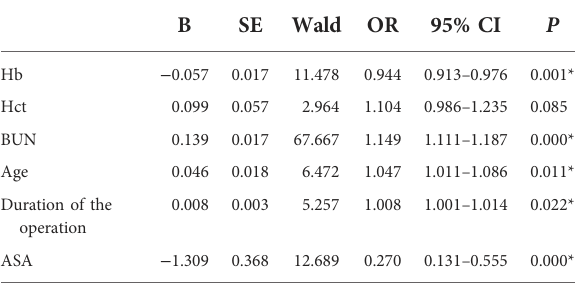
TABLE 2 Multivariate logistic regression analysis of early complications after SBTKA.